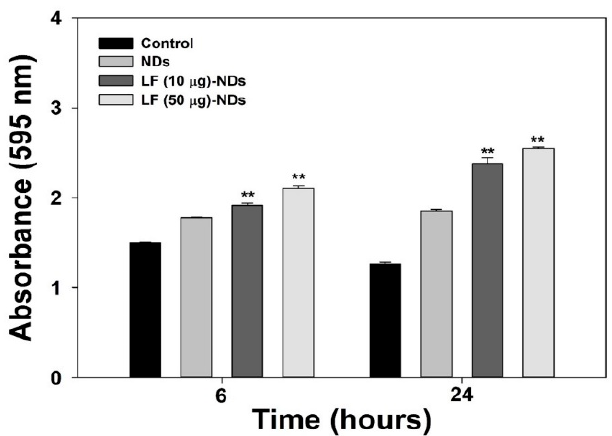
Figure 6. Cell viabilities of MC3T3-E1 cells treated with NDs with or without LF at 6 and 24 h after pre-treating under 300 μ M H 2 O 2 condition. The error bars represent mean ± standard deviation ( n = 4). p value is a comparison between LF-conjugated NDs and NDs. ** p < 0.01.